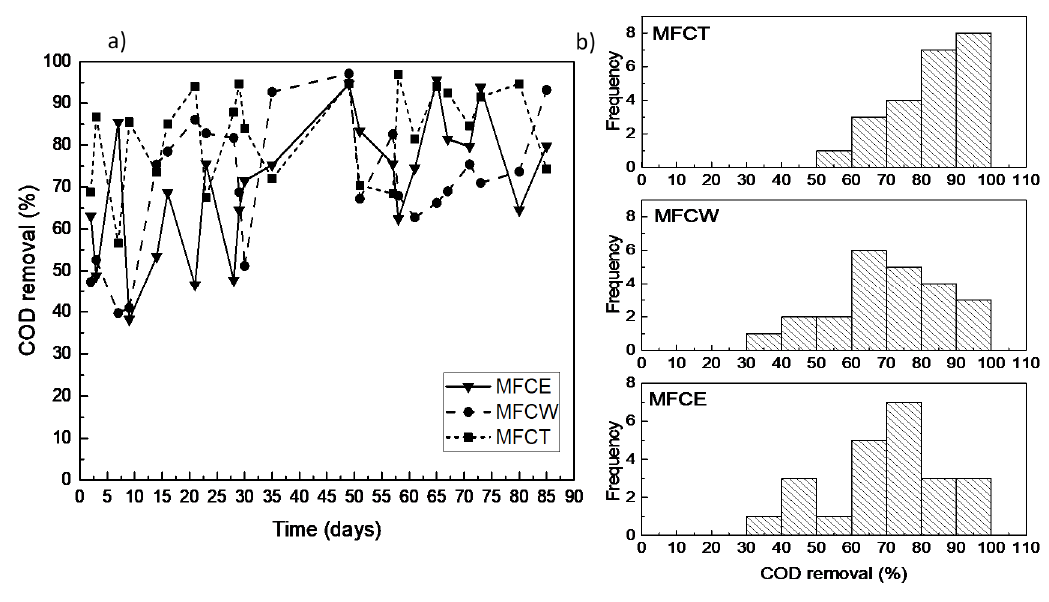
Figure 1. ( a ) COD removal in the microbial fuel cells (MFCs); ( b ) distribution of COD removal.